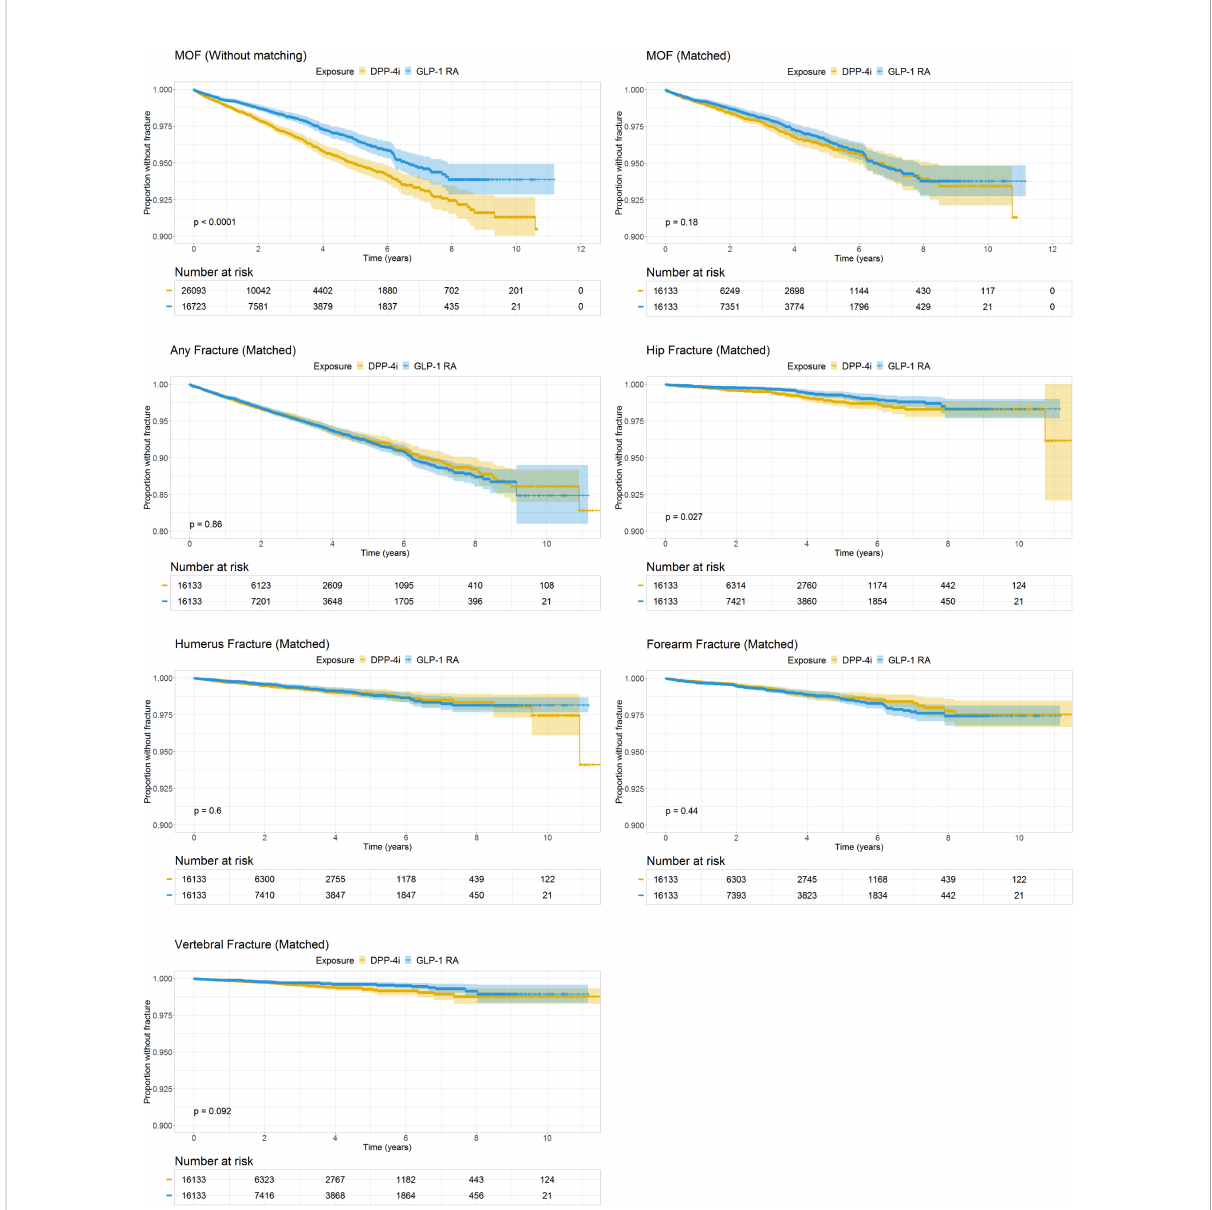
FIGURE 2 Kaplan-Meier Survival Curves of fracture. Survival curves are presented with number-at-risk tables. Time in years on the x-axes. Note, the y-axes go from 0.80 or 0.90 to 1.00. DPP-4i, dipeptidyl peptidase 4 inhibitor; GLP-1 RA, glucagon-like peptide-1 receptor agonists; MOF, Major osteoporotic